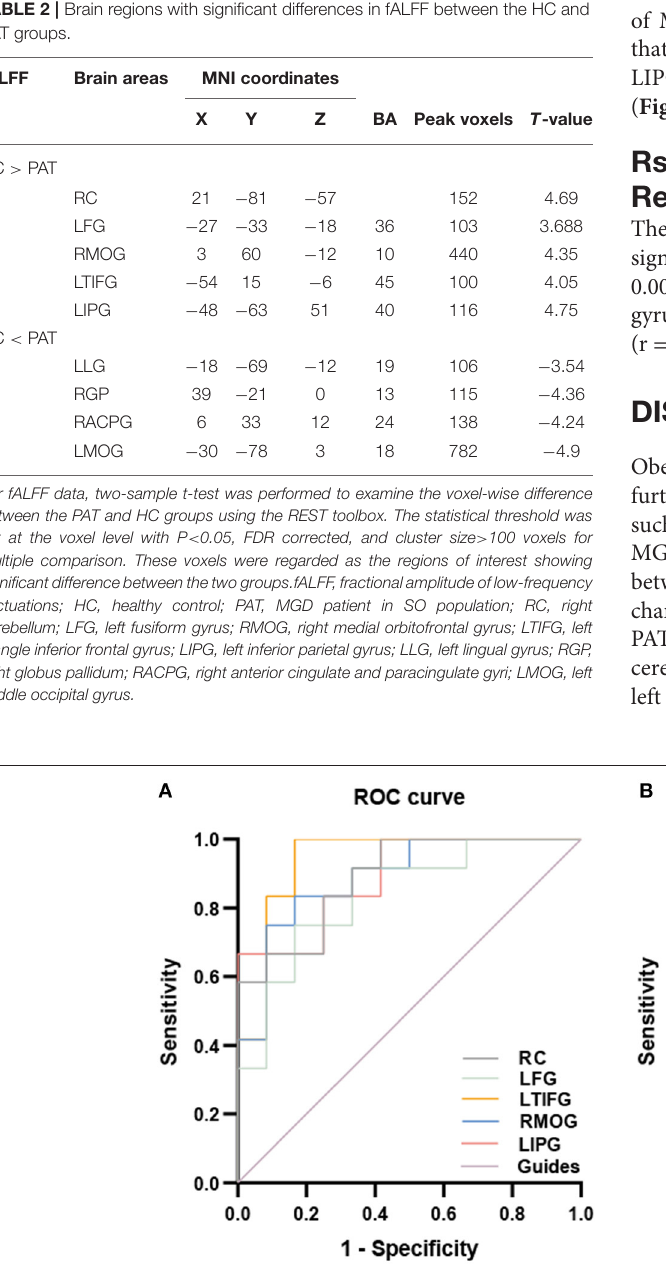
FIGURE 5 | ROC curve analysis of the mean fALFF values for altered brain regions. (A) The area under the ROC curve were 0.8889 ( p < 0.005; 95% CI 0.7620–1.000) for RC, LFG 0.8403 ( p < 0.005; 95% CI 0.6802–1.000), RMOG 0.8889 ( p < 0.005; 95% CI 0.7580–1.000), LTIFG 0.9375 ( p < 0.001; 95%